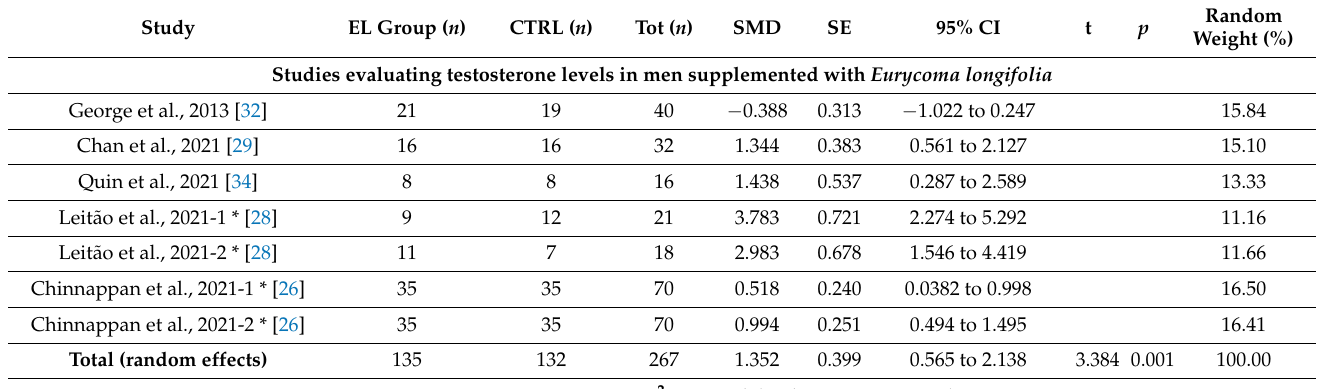
Table 2. Meta-analysis of the outcome variable testosterone in